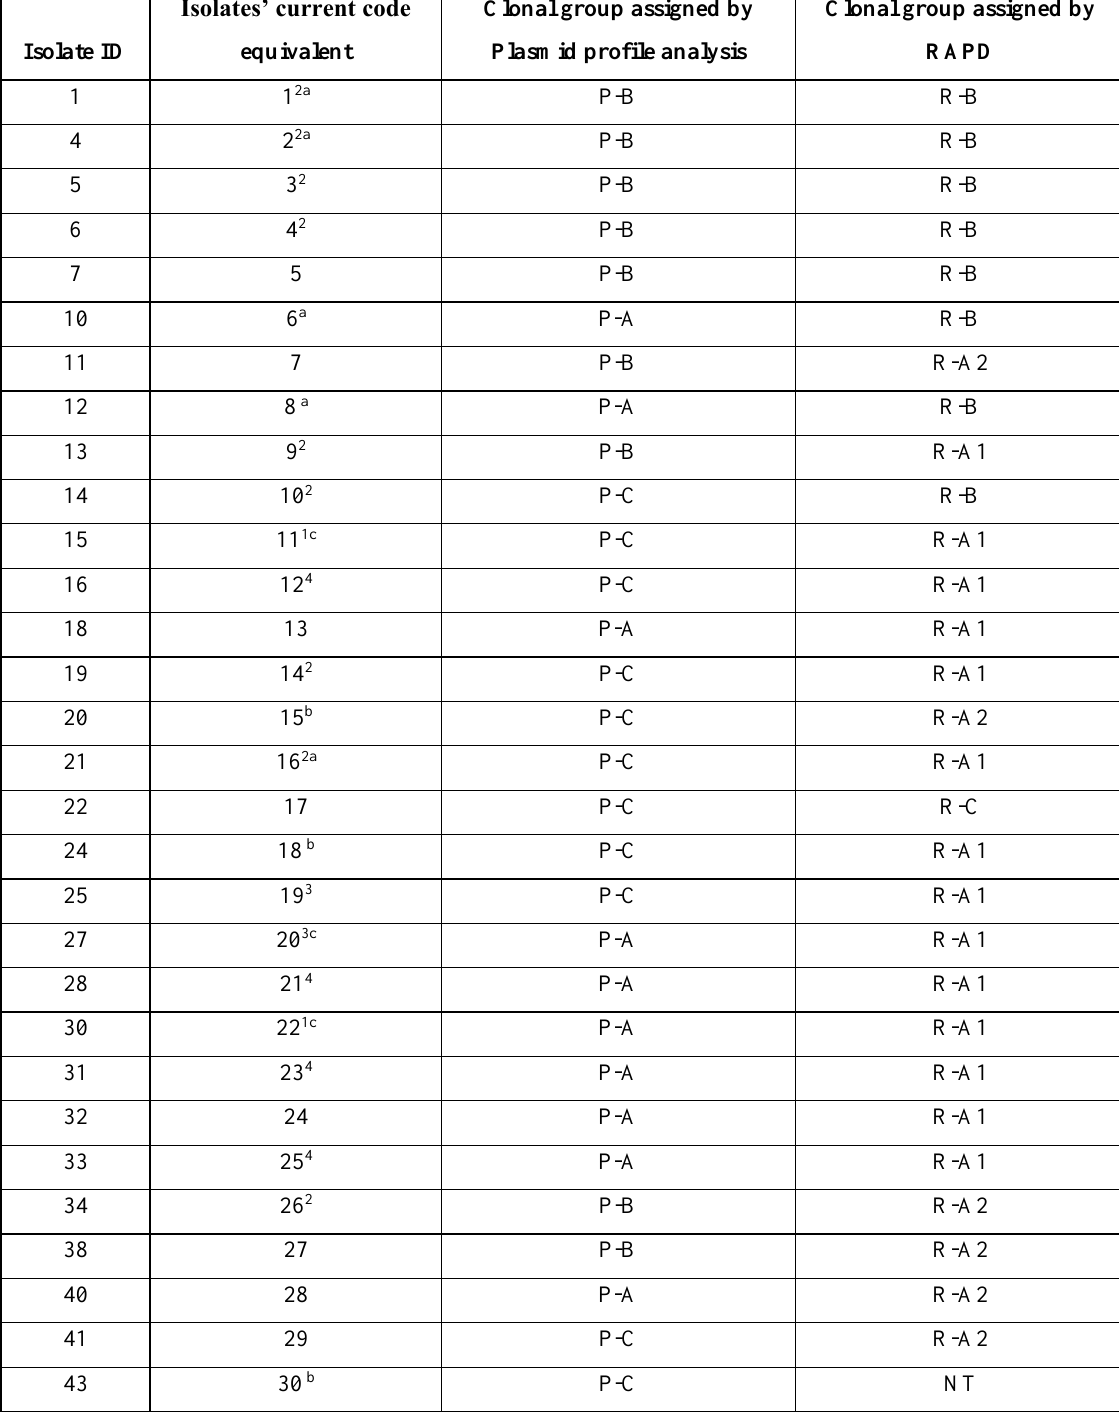
Table S1. Isolates’ ID in the previously published study (14), their code equivalents in the current study, and the clonal groups assigned to the isolates by all 4 applied molecular typing methods Isolate